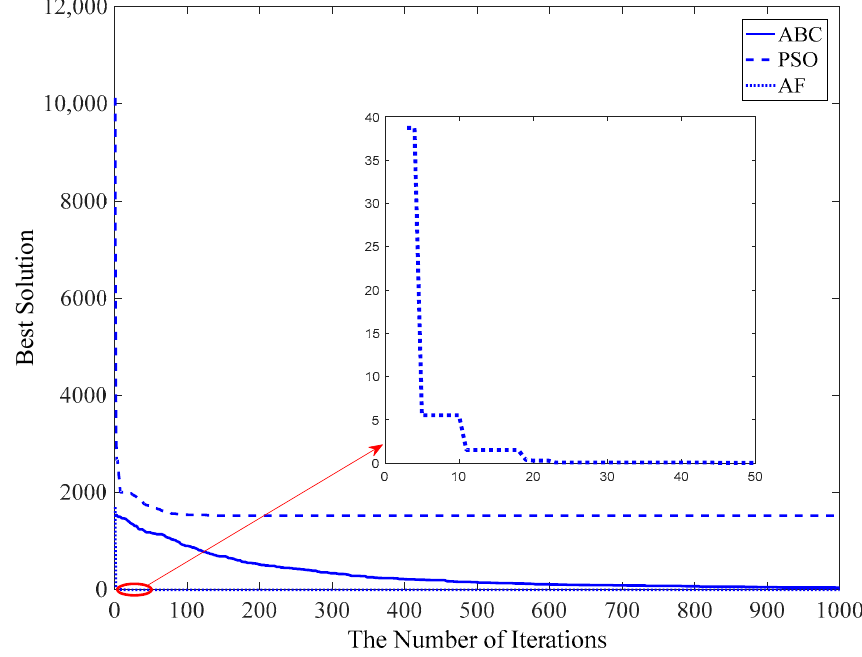
Figure 17. The convergence curve of the three algorithms for Rastrigin function in 100-dimensional space.